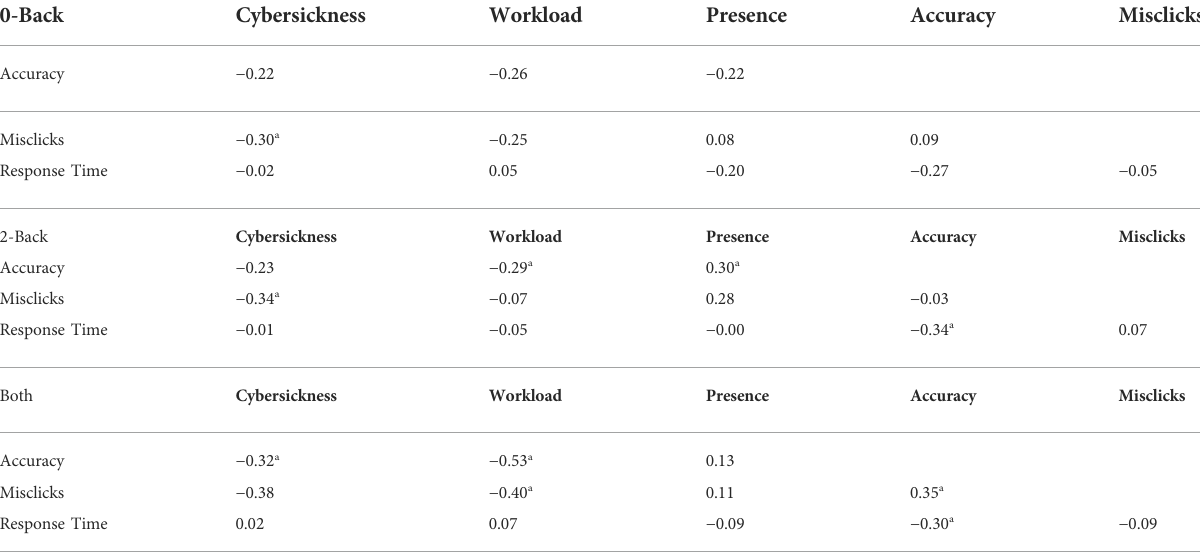
TABLE 3 Pearson ’ s correlations of performance metrics for 0-Back and 2-Back groups individually and combined.